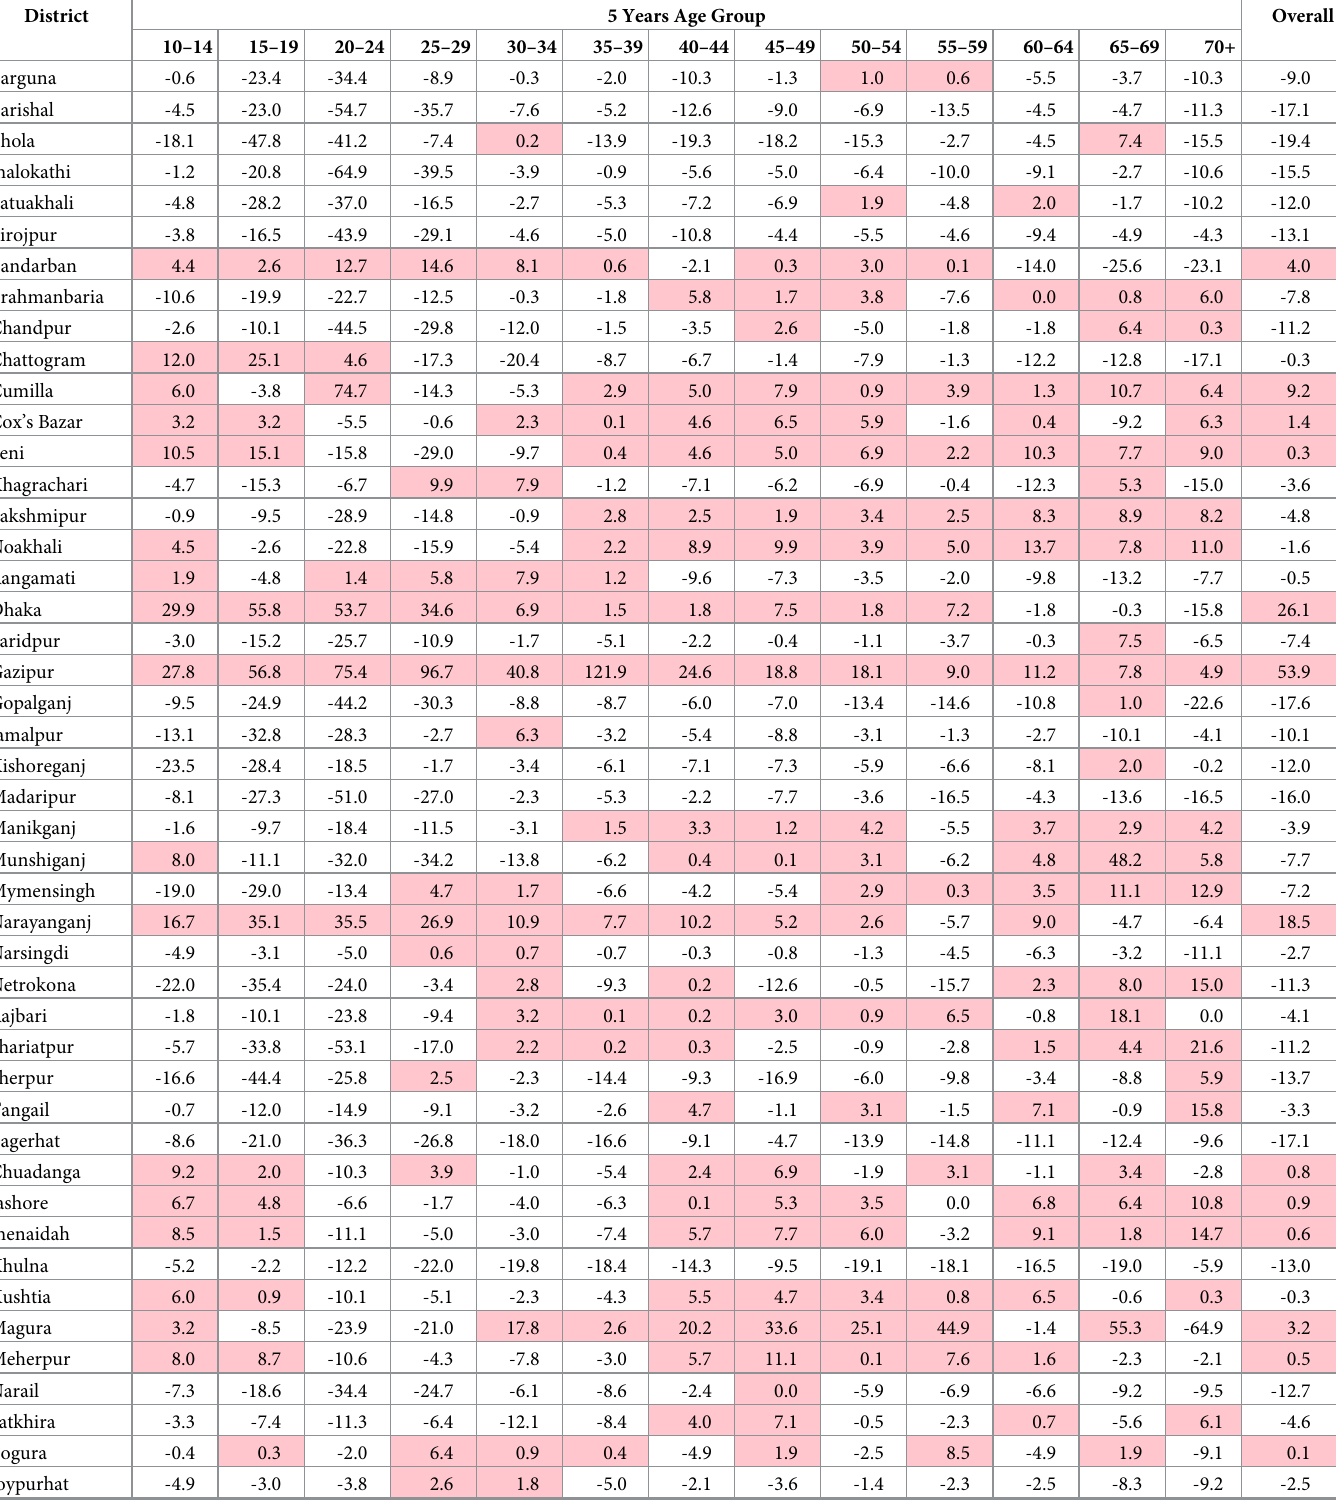
Table 1. Net migration rate by district between 2001 and 2011.